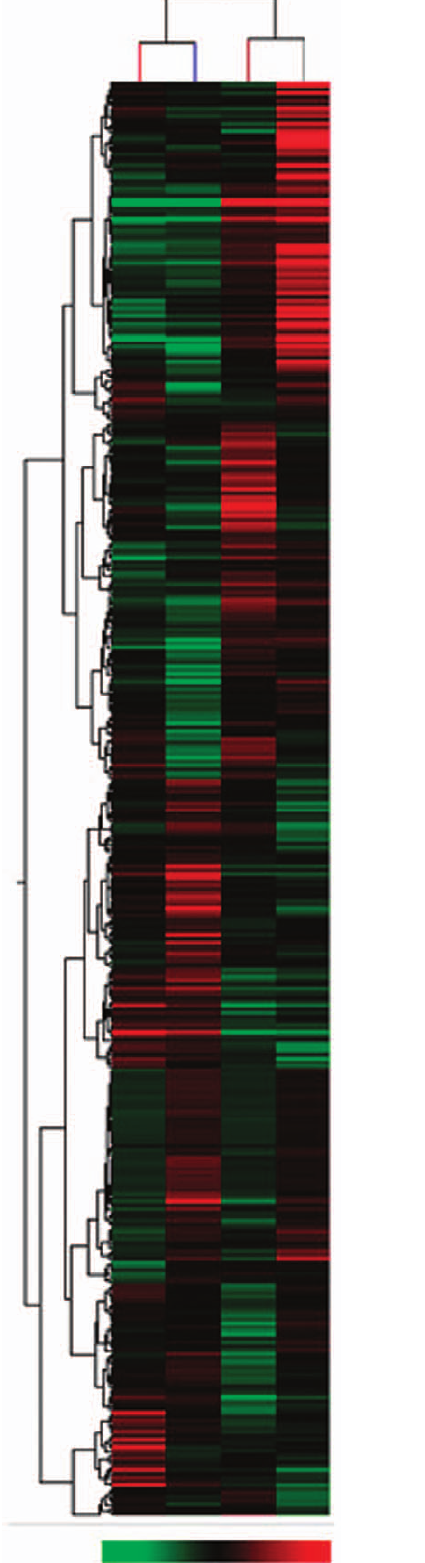
Figure 4. Modulation of mRNAs as evaluated by microarrays during collagen induced arthritis (CIA). Hierarchical clustering and color heat-map of the transcriptome (mRNAs) of CD3 + T cells from the spleen and lymph nodes of 12-week-old mice from the resistant DBA-2/ J strain and the susceptible DBA-1/J strain immunized with chicken type II collagen, based on microarray expression profiling. The control mice were immunized just with complete Freund’s adjuvant (CFA) without any collagen. The dendrogram and heat-map were obtained using cluster and tree-view algorithms through Agilent GeneSpring platform. This figure shows the expression of genes related to immune system function based on Gene Ontology (GO terms). Heat map legend: Red=up regulation, green=down regulation, black=unmodulated (Pearson correlation metrics). Sample dendrogram legend: red-line=- DBA-1/J control; blue-line=DBA-1/J CIA; brown-line=DBA-2/J control; gray-line=DBA-2/J